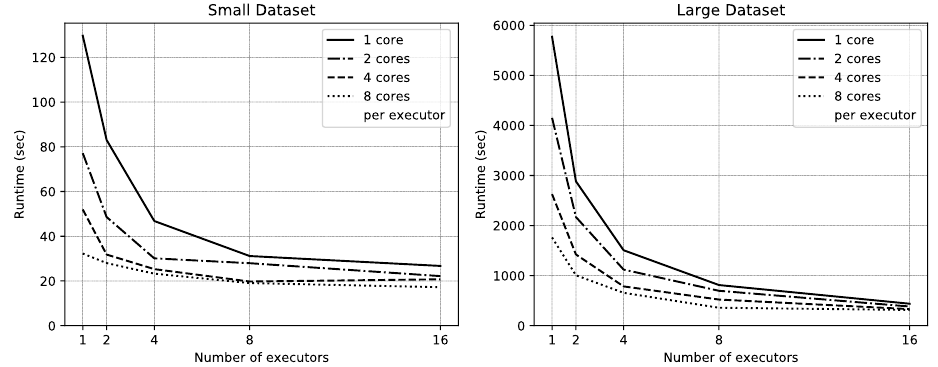
Figure 13. Efficiency of the lower layer of parallelization—overall, the runtime reduced when the numbers of executors and cores increased. The runtime reduction is much more obvious in the experiments using the Large